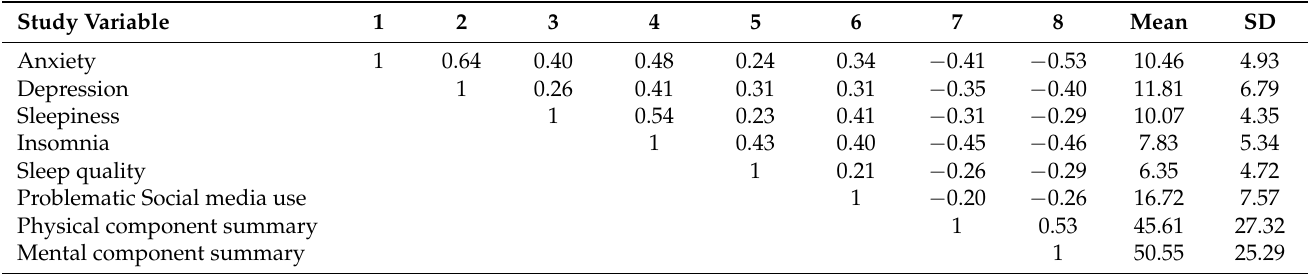
Table 2. Correlation matrix between the study’s variables.